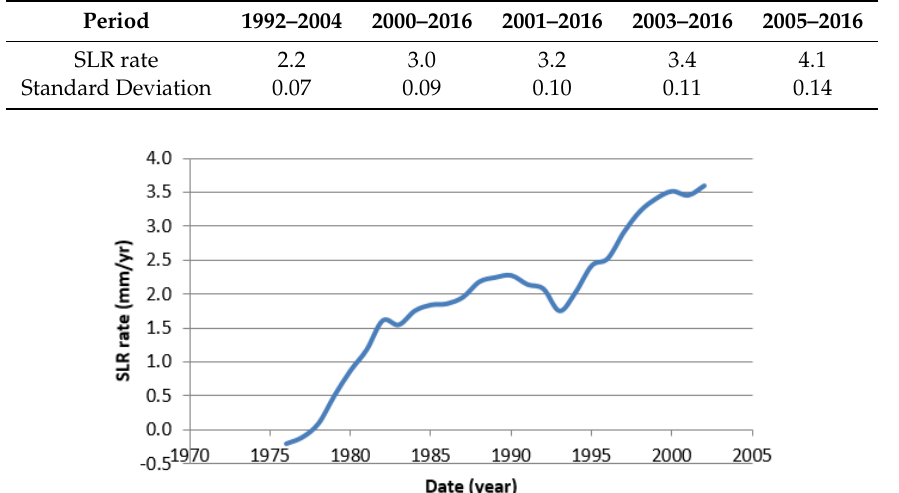
Table 1. SLR rates and respective standard deviation (SD) for different periods (in mm/yr), 1992 to 2004 from secular monthly mean series, and 2000 to 2016 from decadal daily mean series.